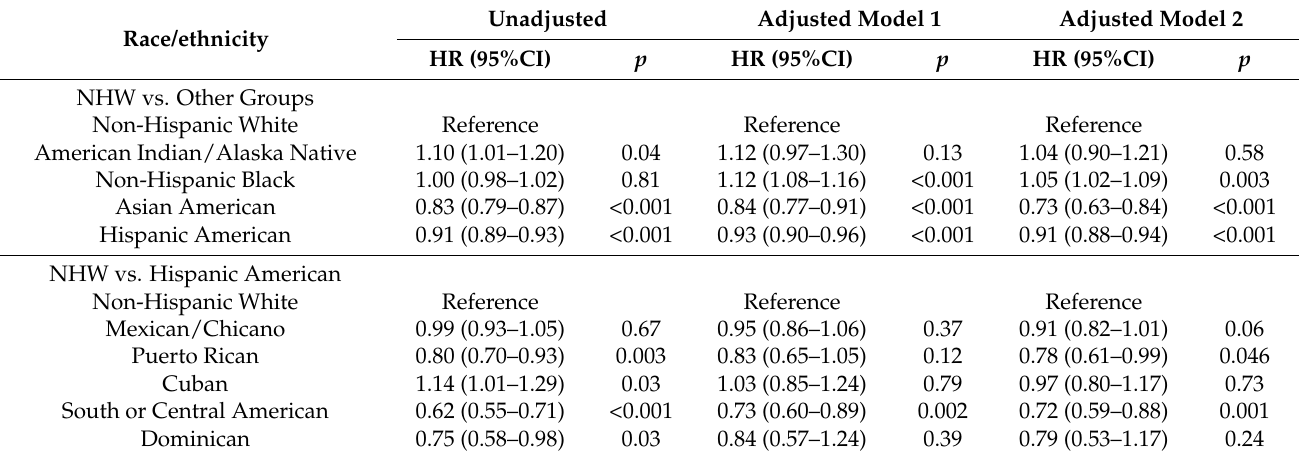
Table 2. Cox Regression analysis for all-cause mortality in